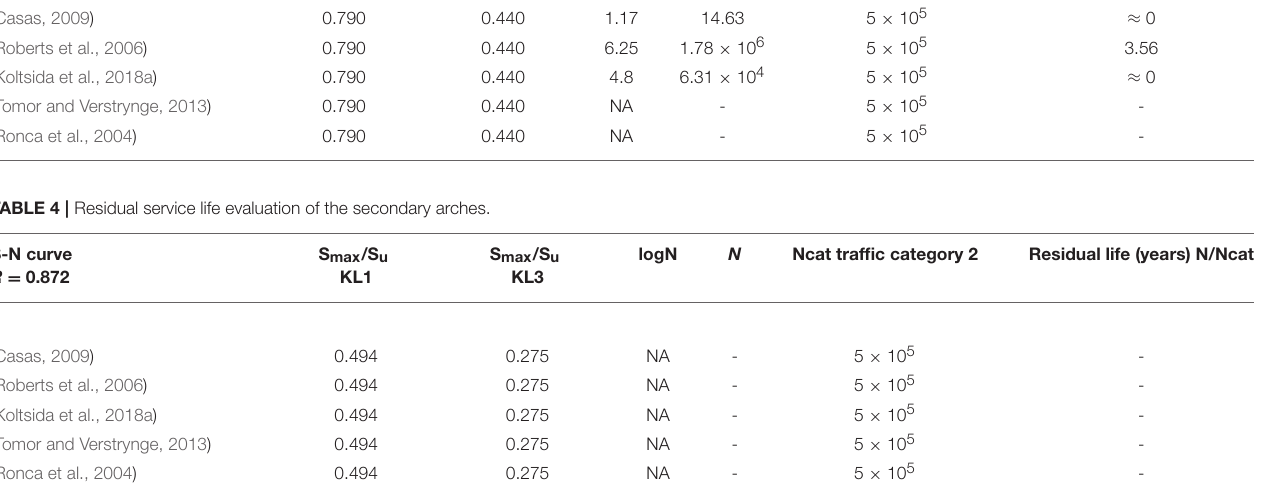
TABLE 3 | Residual service life evaluation of the main arches. S-N curve R = 0.868